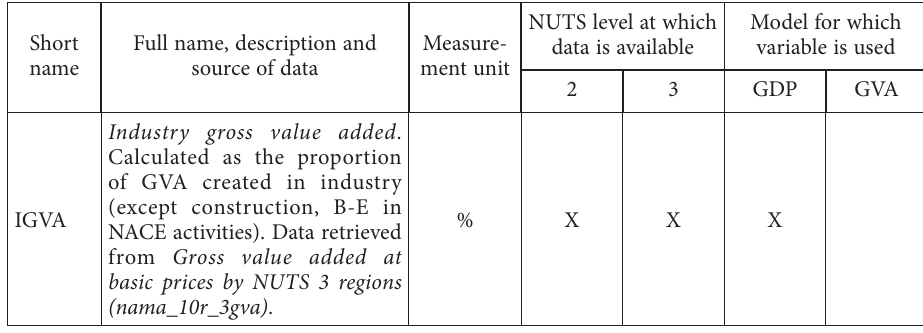
Table A3. Analysis of overfunding Dis- Estimated turning aggre- point of positive gation marginal effect on level